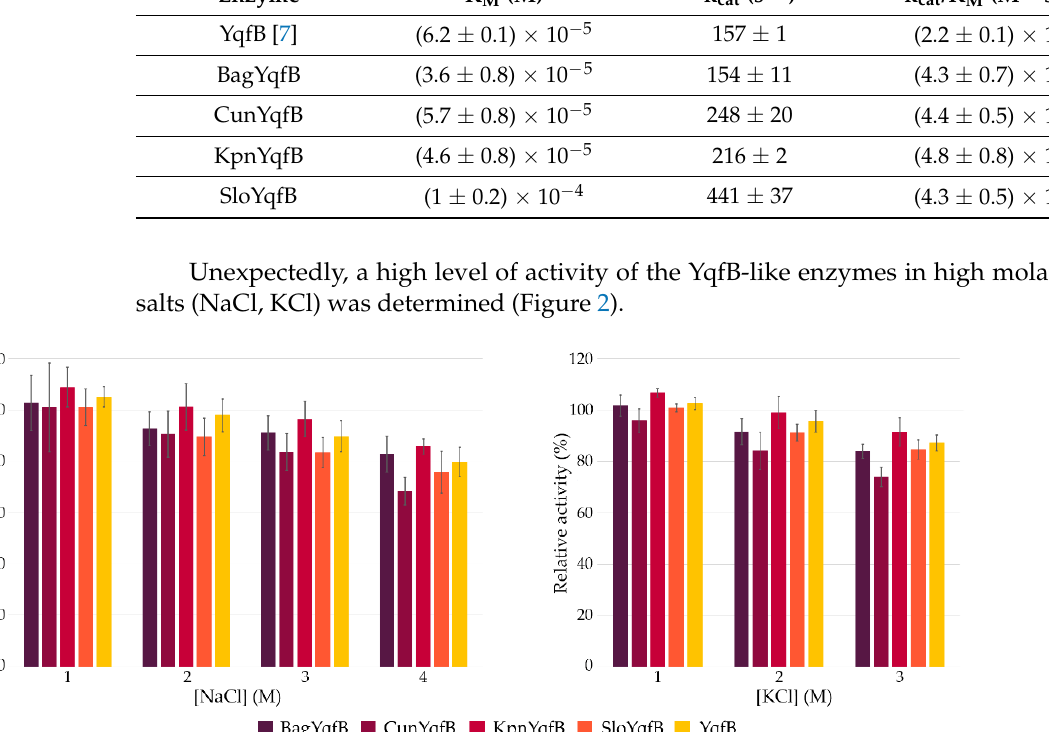
Table 2. Kinetic parameters of YqfB and ASCH domain-containing YqfB-like proteins. The activity was measured in 20 mM Tris-HCl, pH 7.5, at 22 ◦ C, using ac4C as a substrate. Enzyme K M (M)